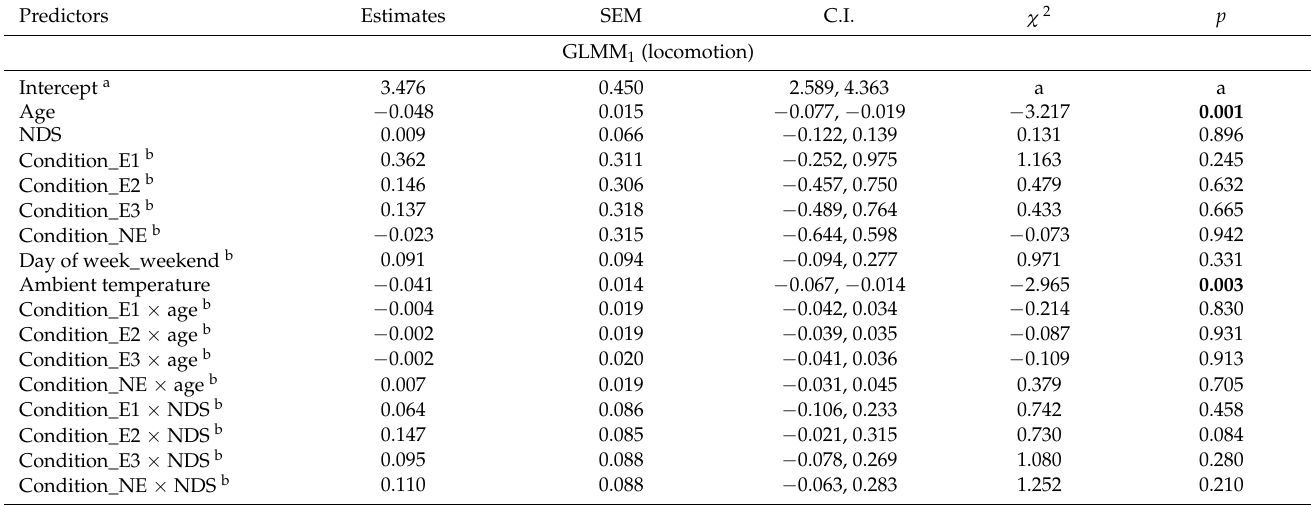
Table 3. Full results of GLMs on the effects of enrichments and environmental/individual factors on the lemurs’ behaviors (N cases = 210). Significant results are reported in